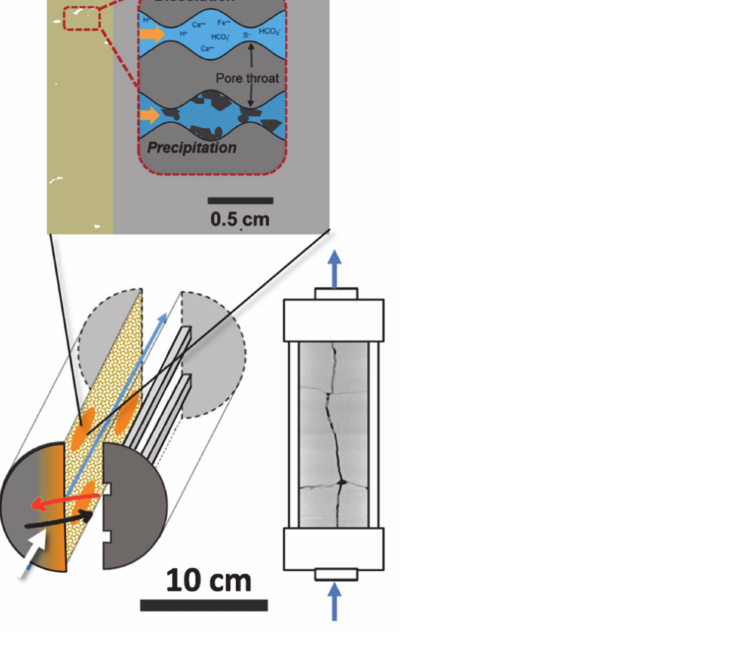
Figure 15. Schematic showing the two types of reaction experiments conducted on Wolfcamp Shale from the HFTS Project, with flow-through reaction experiments in fracture at the bottom and batch reaction experiments on shale surfaces at the